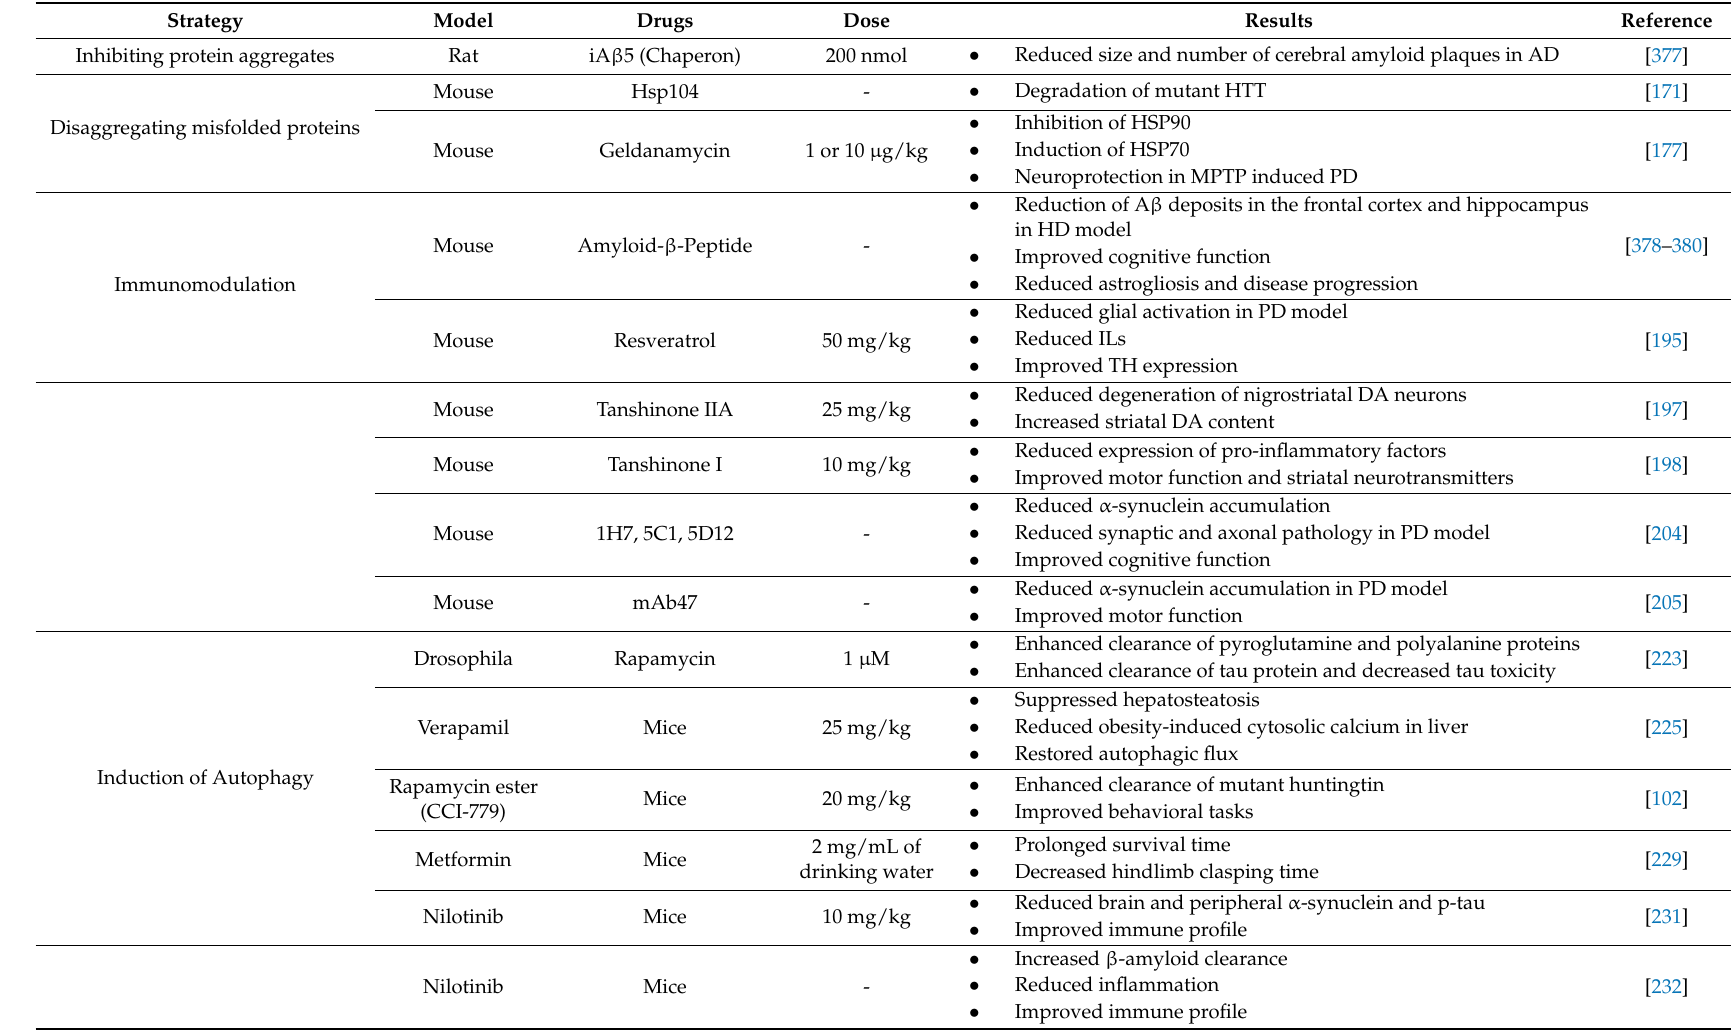
Table 1. Summary of novel treatment strategies for neurodegenerative